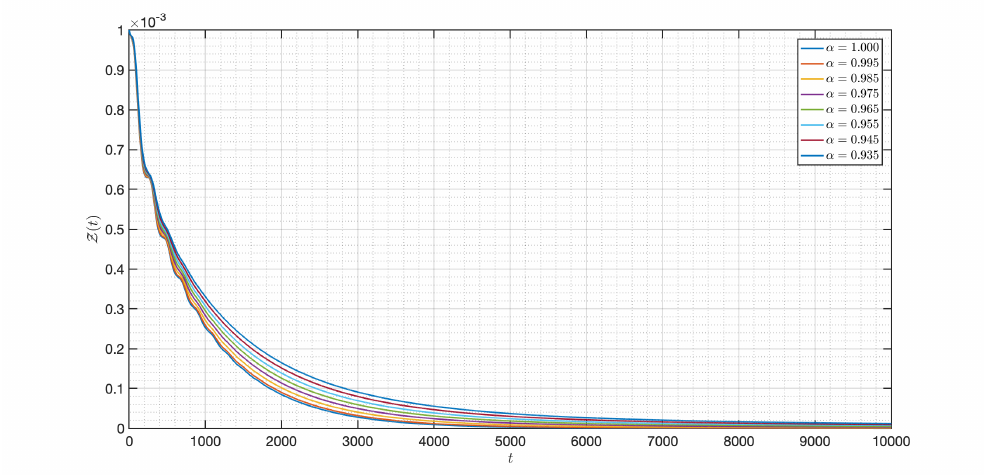
Figure 27. Dynamic of Z ( t ) the model (3) for different parameters in Case III .